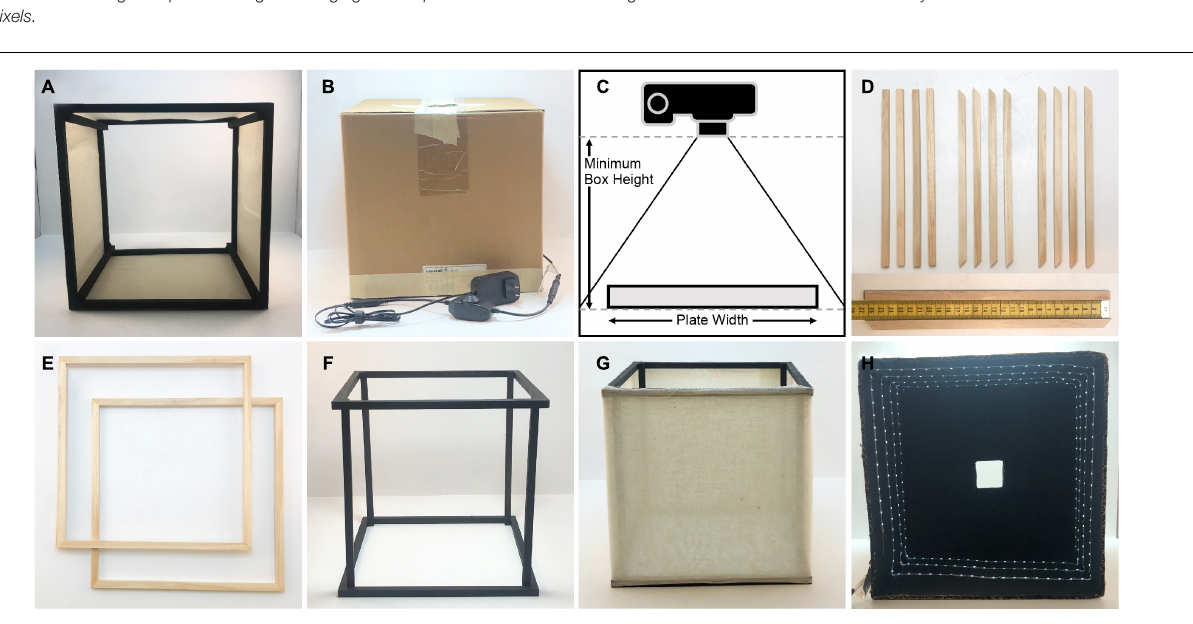
the plate, and for the replica plate the line was drawn through the middle of a row of colonies. For both plates the rectangle was drawn in the center of the plate so as to not hit the edges of the plate. For the profile plot, red, green and blue (RGB) pixel intensities are reported. For the three-dimensional surface plots, the RGB pixel intensities were converted to grayscale in ImageJ using the formula V = (R + G + B)/3 to report a single “brightness” value. To quantify the reduction in glare, the standard deviation of the brightness for the pixels in the area used for the three-dimensional surface plot was